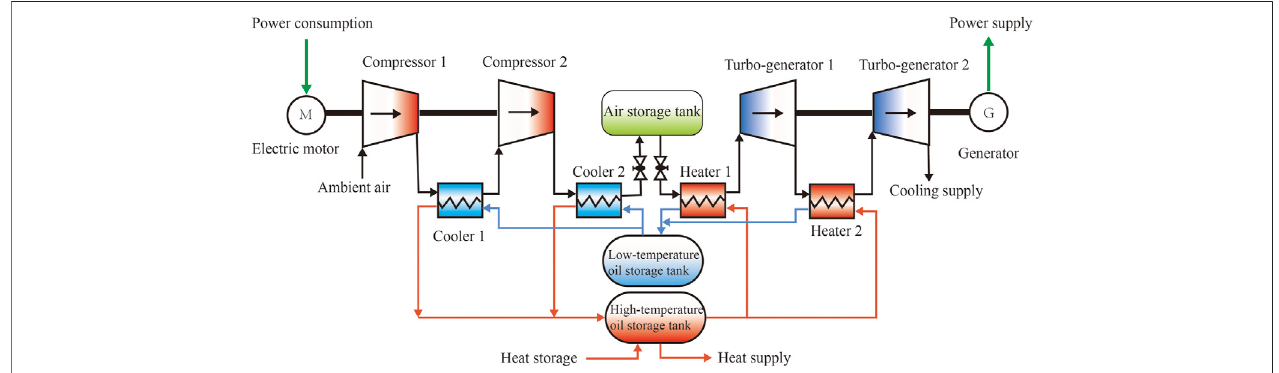
FIGURE 2 | AA-CAES structural